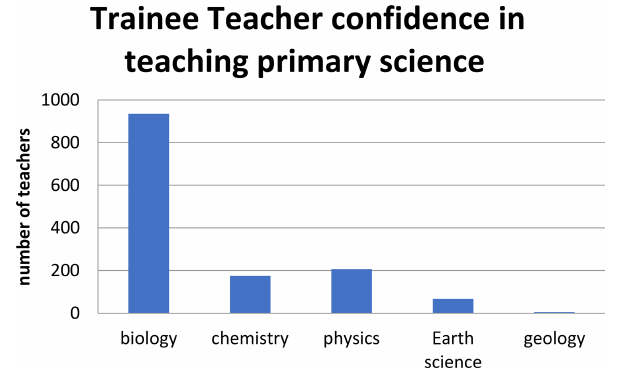
Figure 2. Bar graph showing overall trainee teacher confidence in teaching primary science from